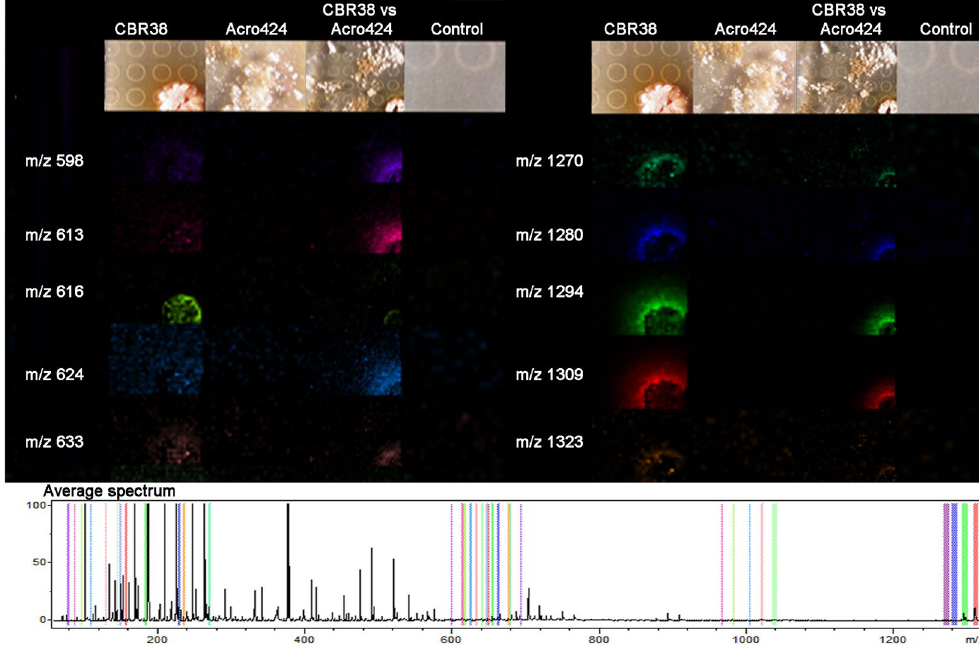
Figure 3. MALDI-TOF imaging mass spectrometry experiment of the bacterium Streptomyces CBR38 vs Escovopsis ACRO424. Selected ions observed in the microbial interaction are presented as columns, first column show mass to charge ratio, second to fifth columns display false-colored images of the spatial distribution of the ions detected around: Streptomyces CBR38; Escovopsis ACRO424; Streptomyces sp. vs Escovopsis sp.(CBR38 vs ACRO424); and SFM Agar. Average mass spectrum highlighting all the selected ions is show at the